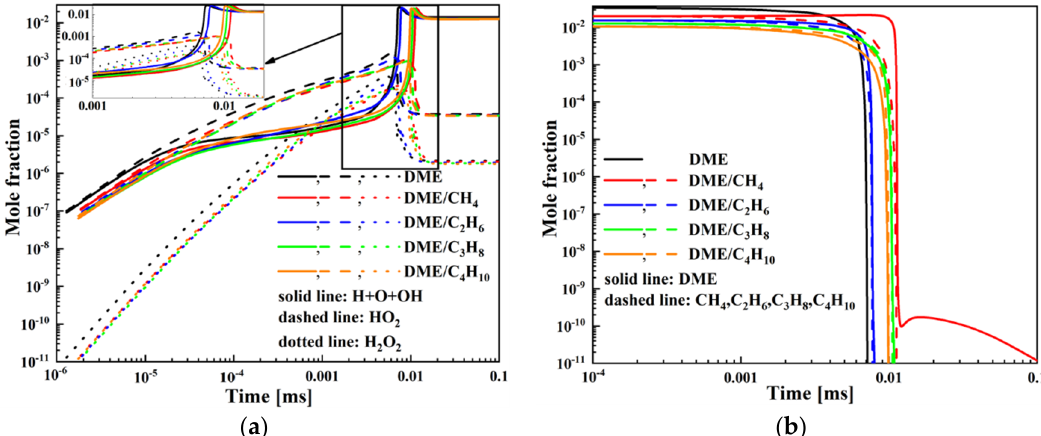
Figure 7. Mole fraction of various species for DME/C1-C4 alkane mixtures at T c = 1500 K, P c = 20 bar, and φ = 0.5: ( a ) H, O, OH, HO 2 , H 2 O 2 and ( b ) DME, CH 4 , C 2 H 6 , C 3 H 8 , C 4 H 10 .